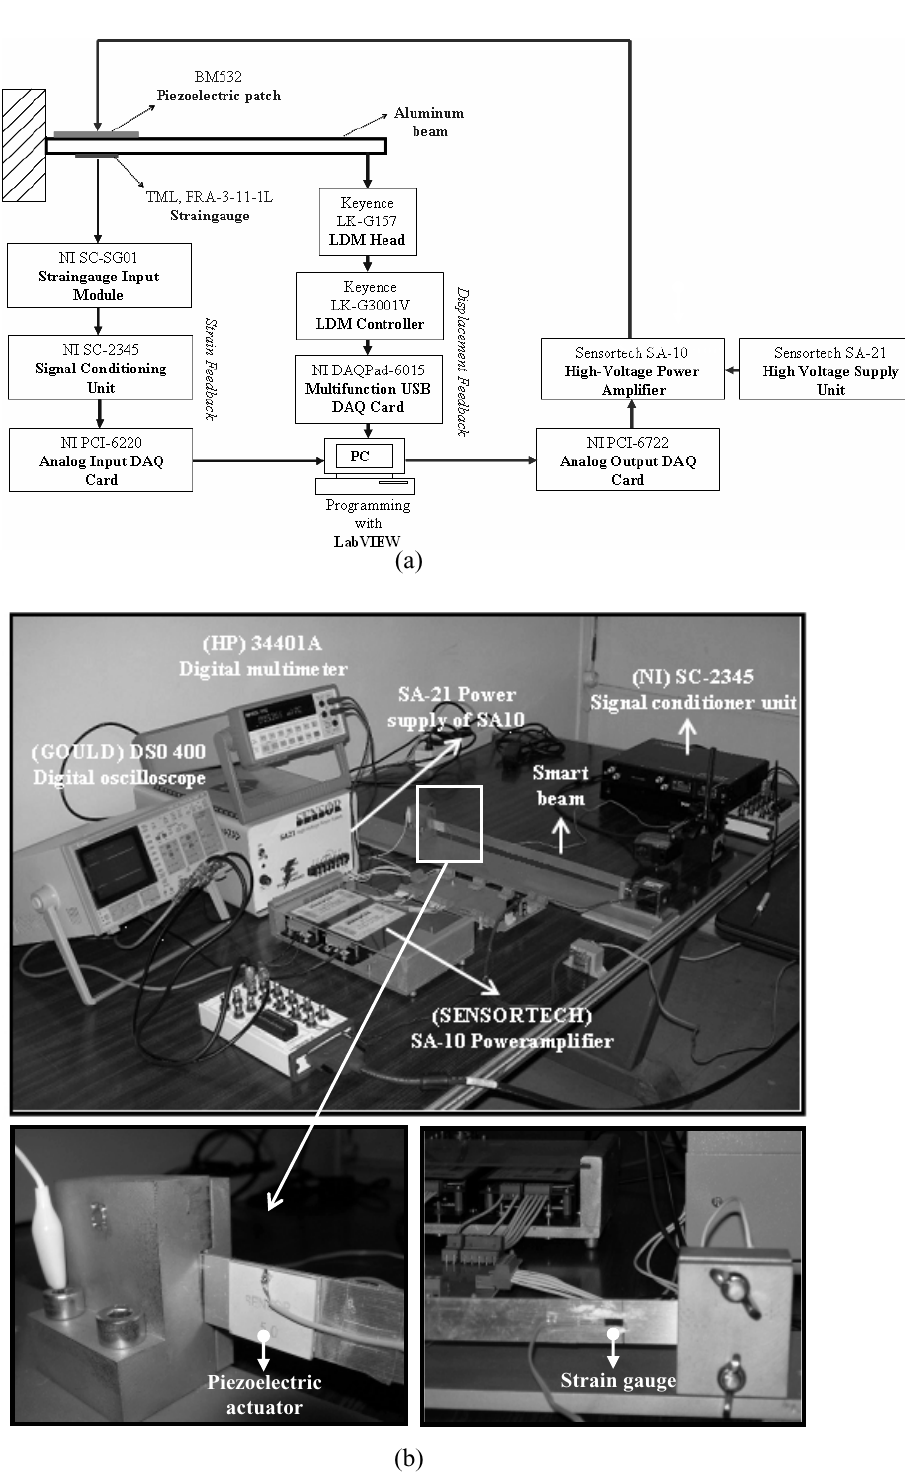
Fig. 4. Experimental setup (a) schematic view for Case 1, (b) photographic